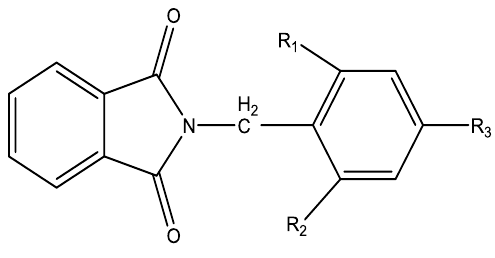
Figure 1. Phthalimide moiety connected to substituted phenyl ring by an alkyl chain Materials and